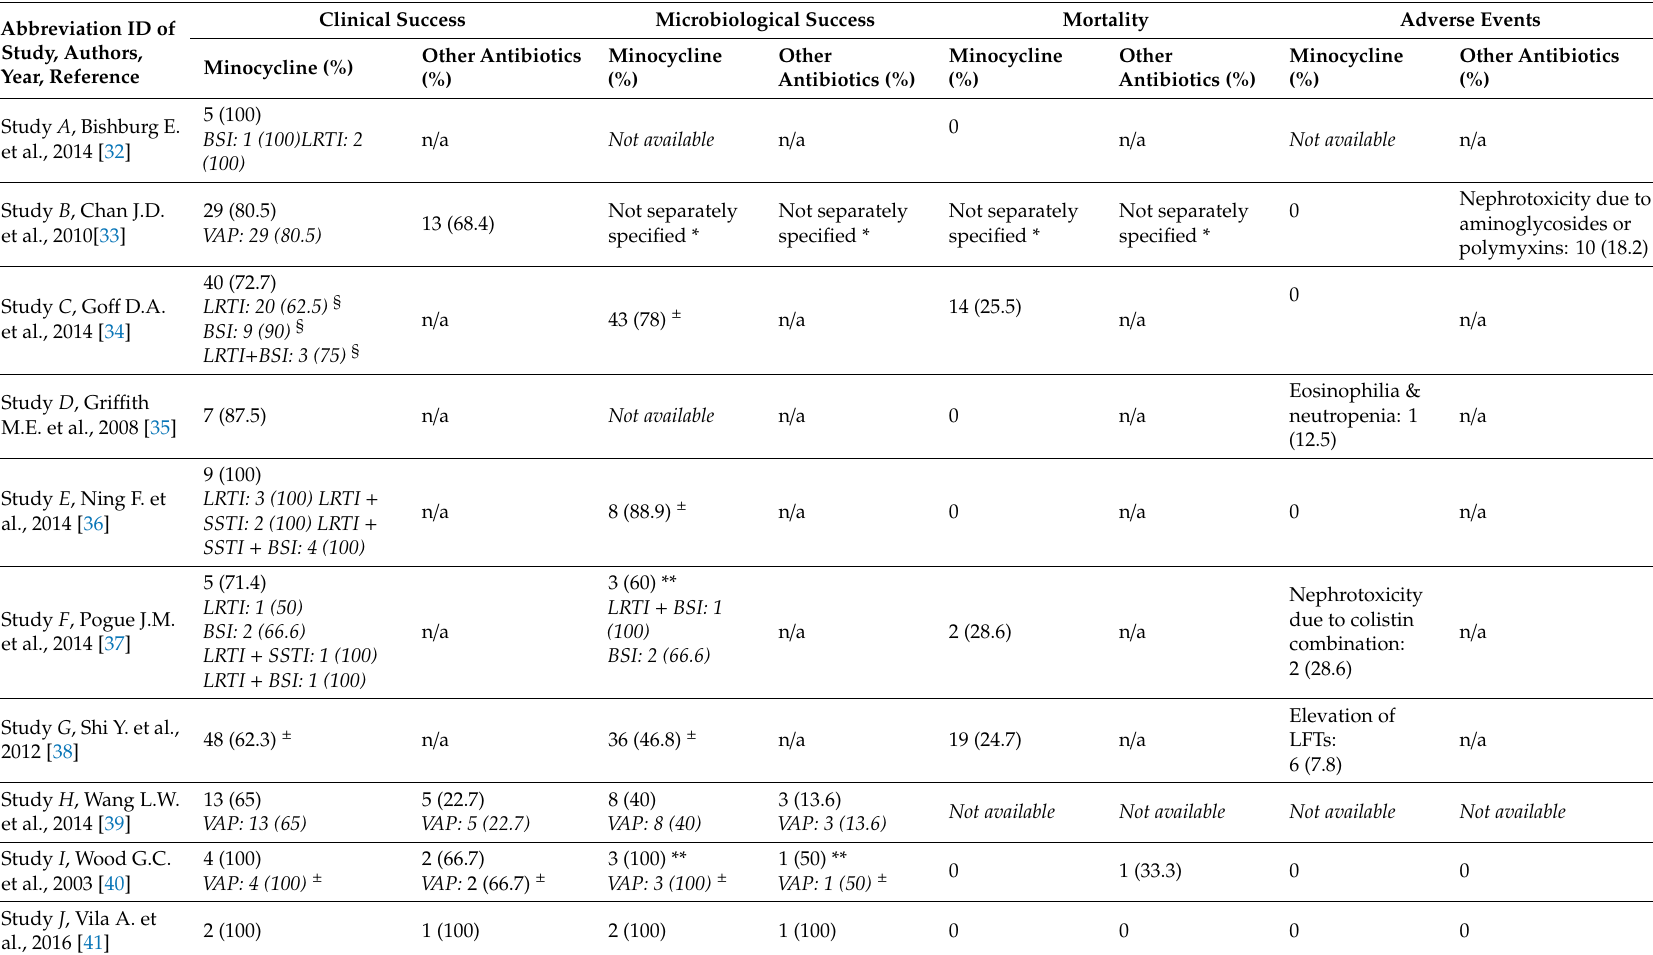
Table 4. Outcomes of included clinical